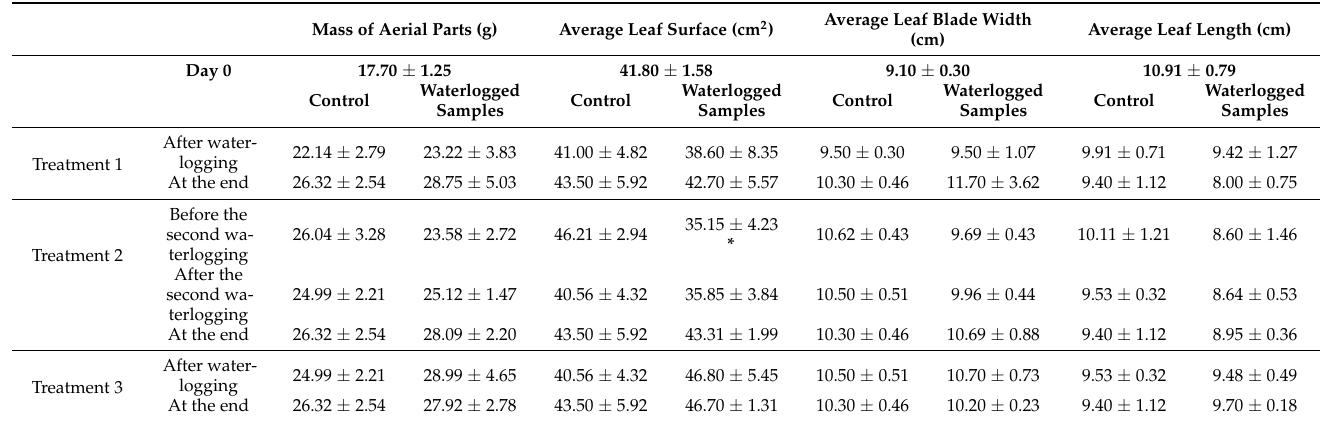
Table 4. Waterlogging effects on biomass and morphological characteristics of waterlogged white cabbage plants.